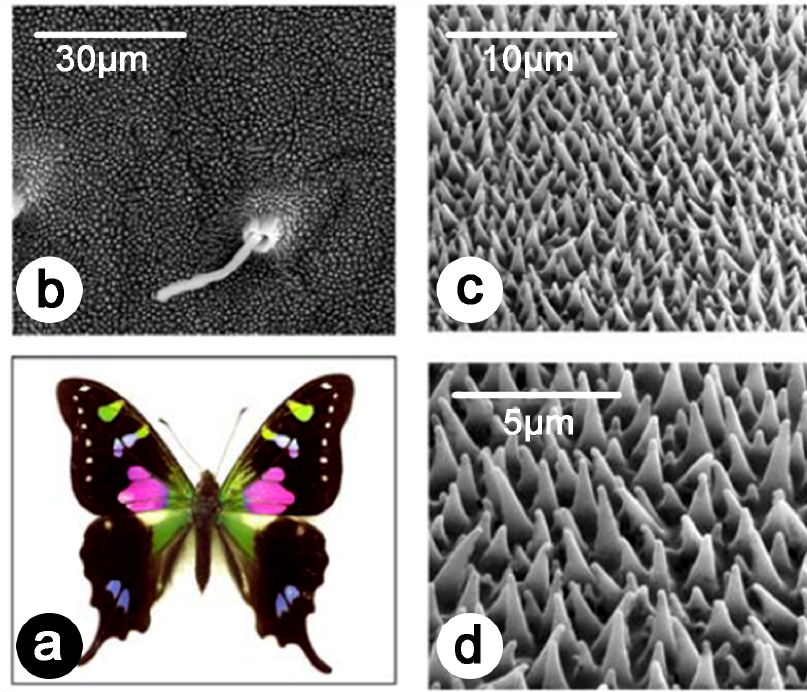
Figure 8. The structures occurring on the wings of the purple spotted swallowtail butterfly ( Graphium weiskei ) coated with a metal thin film were found to be an excellent substrate for SERS, in terms of biocompatibility and sensitivity [108–110]. G. weiskei ( a ) exhibit conical microstructures on its wings ( b – d ) as observed here by SEM. After coating by gold or silver, these structures can be used to detect protein binding from direct observation of the modifications in the SERS response. Reproduced from Garrett, N. L., Vukusic, P., Ogrin, F., Sirotkin, E., Winlove, C. P., and Moger, J., 2009, Spectroscopy on the wing: Naturally inspired SERS substrates for biochemical analysis, J. Biophot. 2(3), 157–166.